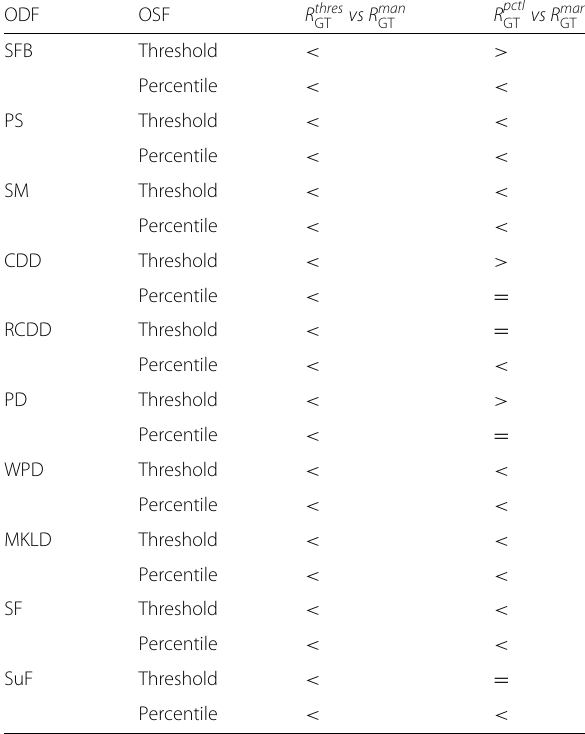
Table 5 Statistical significance results of the user effort invested ) in the correction of the detected onsets. Manual correction ( R man GT ) and percentile- is compared against the threshold-based ( R thres GT ) interactive correction methods. Symbols < , > and = based ( R pctl GT state that effort invested with the interactive methodologies is significantly lower, higher or not different to the results by the manual correction. Significance has been set to p <